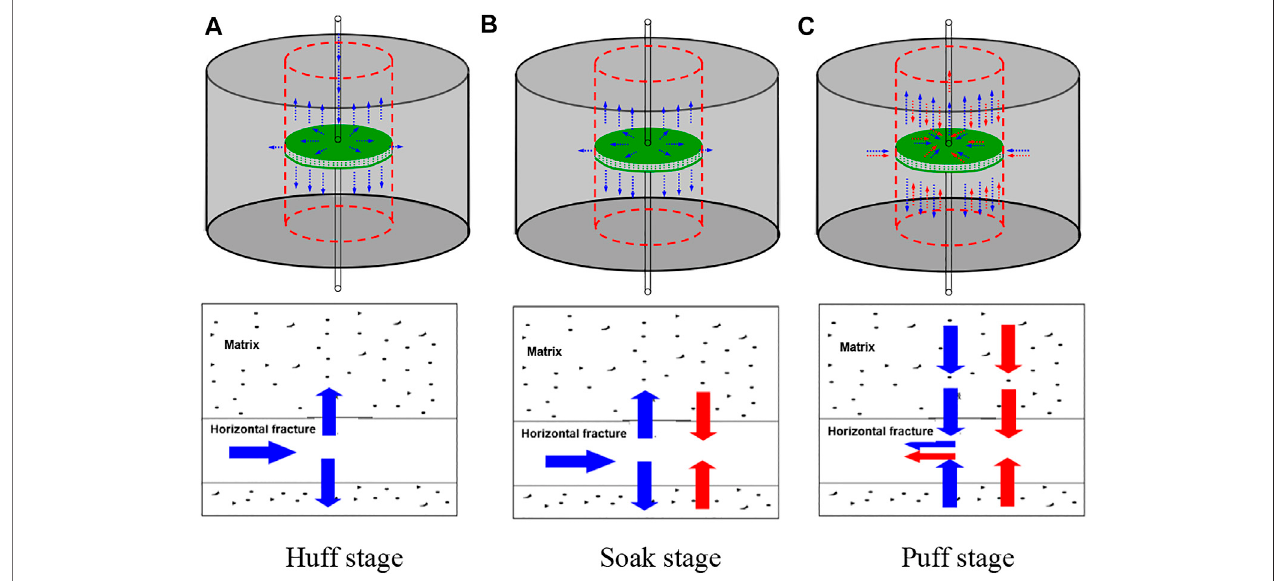
FIGURE 1 | Schematic diagram for the water huff-n-puff in low-permeability reservoirs with a horizontal fracture. (A) Huff stage, (B) soak stage, (C) puff stage.